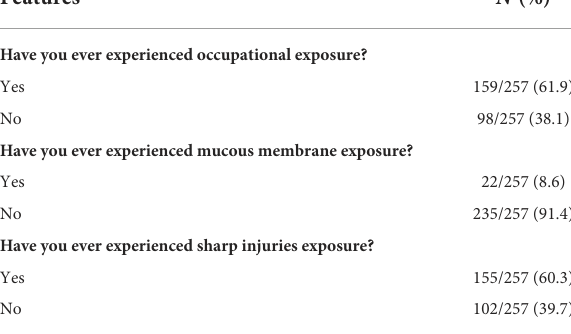
TABLE 2 Number (percentage) of participants who have experienced occupational exposure ( n =